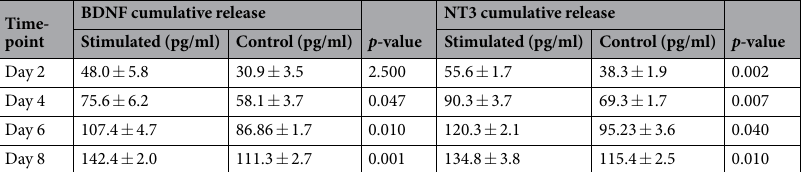
Table 1. Summary of cumulative release profile of BDNF and NT3 in SMF stimulated and control OPCs. Date is represented as mean ±